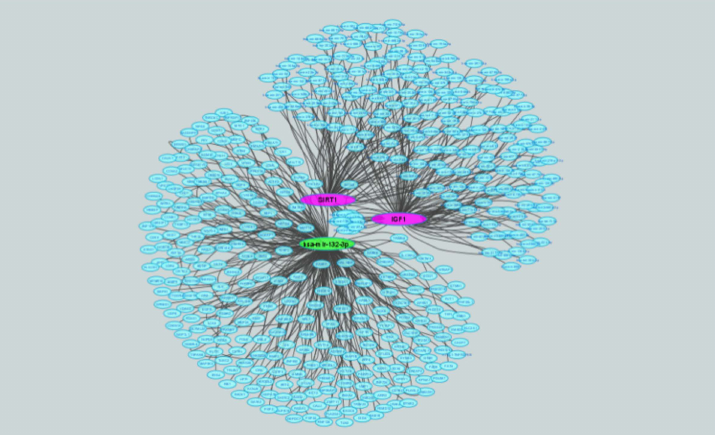
Figure 6. Graphic representation of the IGF1, miR-132-3p-SIRT1 loop. Network visual analysis of predicted targets of miR-132-3p and two key genes, SIRT1 and IGF1. The analysis identified 1668 entries of miR-gene interactions, which are presented using Cytoscape v. 3.7.2. miR-132-3p is presented in green and SIRT1 and IGF1 are presented in pink. All other interactions are shown in smaller light blue